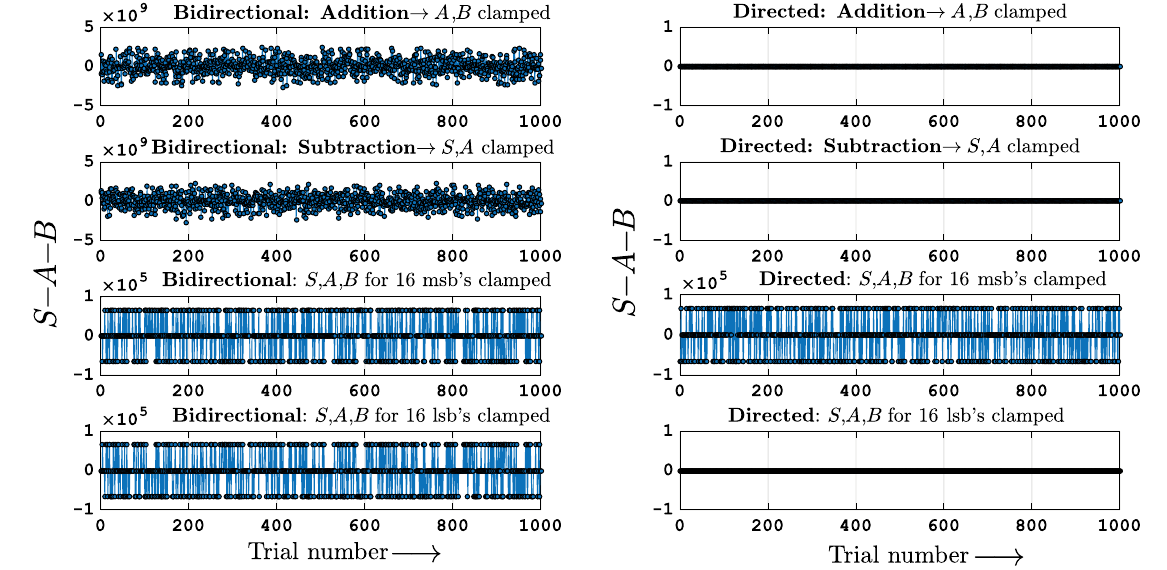
FIG. 14. Invertibility of 32-bit adder, directed versus bidirectional. An adder that provides the sum S of two 32-bit numbers A and B : S ¼ A þ B . The left-hand panel shows the adder implemented with bidirectional carry bits, while the right-hand panel shows one with carry bits directed from the least significant to the most significant bit. Four different modes are shown with (i) A and B clamped (addition), (ii) S and A clamped (subtraction), (iii) A , B , and S for the 16 most significant bits (msb) clamped, and (iv) A , B , and S for the 16 least significant bits (lsb) clamped. Note that the bidirectional implementation shows very large errors for all modes of operation. The directed implementation works perfectly for both the adder and the subtractor modes. It also works if we clamp the least significant bits, but not if we clamp the most significant bits. Correlation parameter I 0 ¼ 1 , T ¼ 100 steps for all trials. S , A , B are taken to be the mode (most frequent value) of the 100 × 1 array obtained at the end of each trial. Clamped inputs are random 32-bit words for each trial, for a total of 1000 trials.